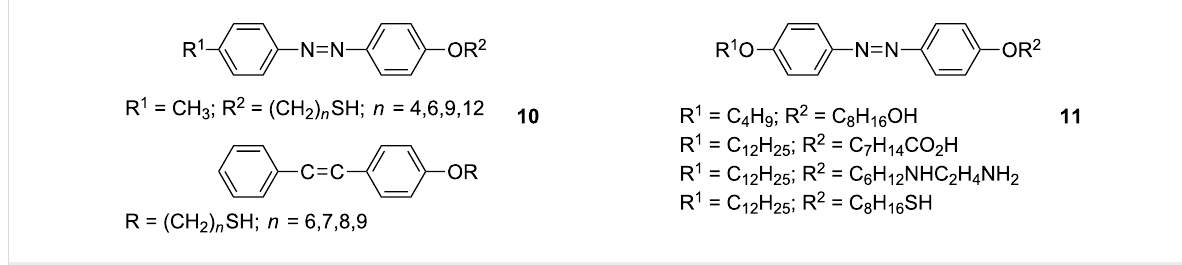
Figure 12: Photochromic and photo-mesogenic rodlike ligands.